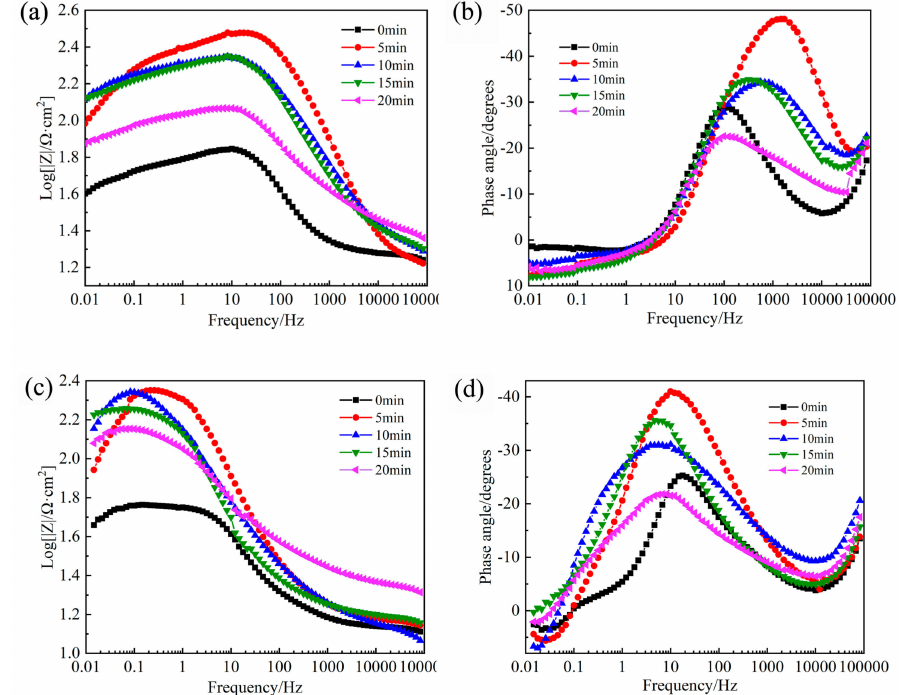
Figure 7. Bode plots of the RASP-processed SA106B specimens. ( a ) Frequency-impedance relation and ( b ) frequency-phase relation in the 0.05 M H 2 SO 4 + 0.05 M Na 2 SO 4 solution. ( c ) Frequency-impedance relation and ( d ) frequency-phase relation in the 0.2 M NaCl + 0.05 M Na 2 SO 4